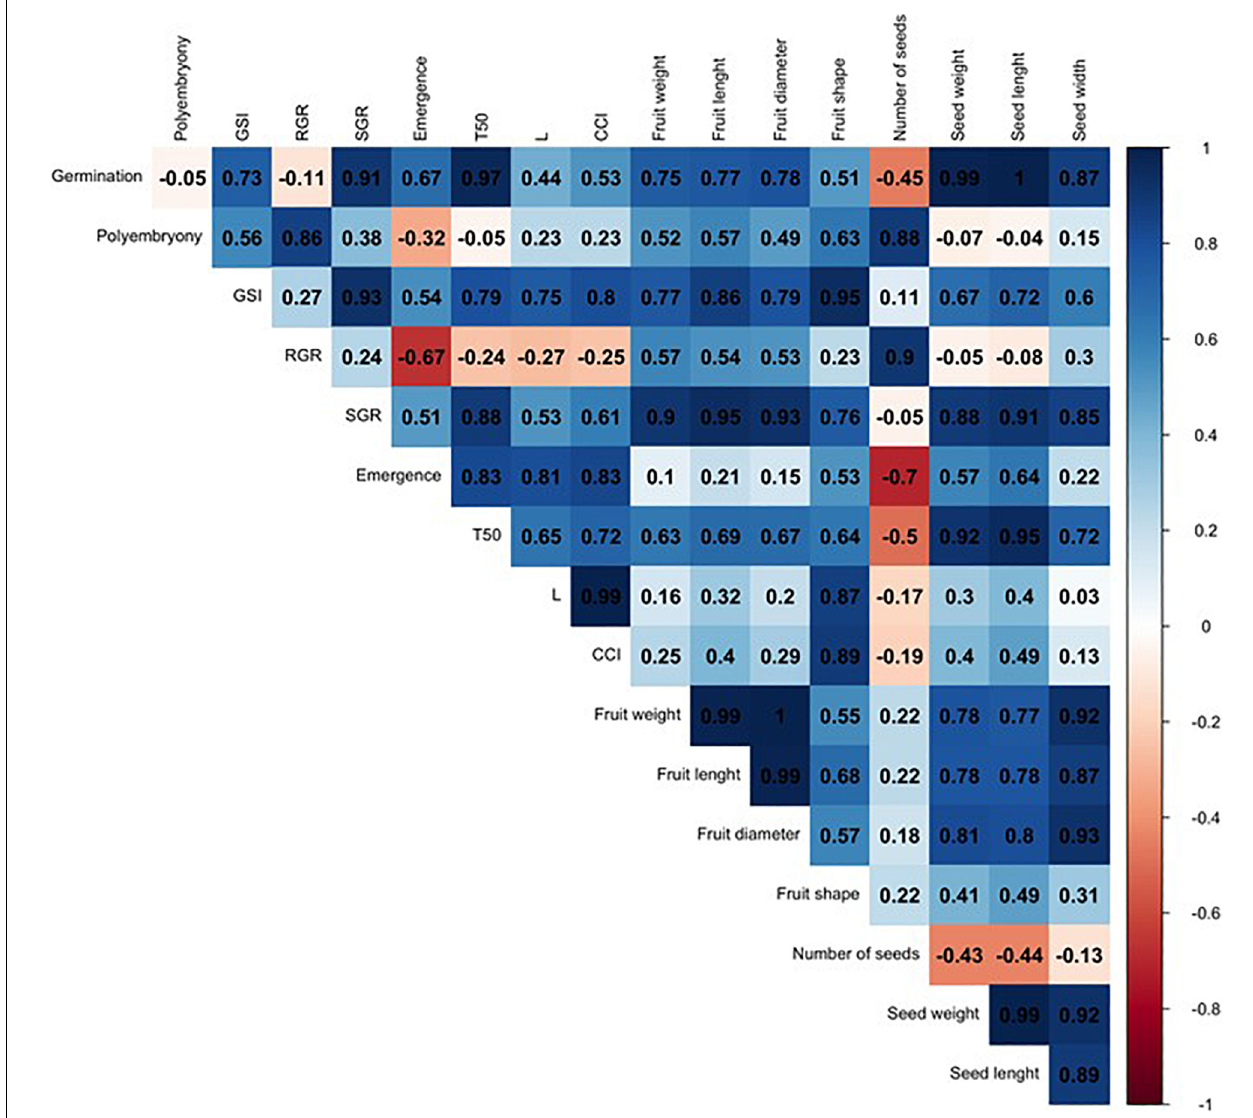
FIGURE 7 | Correlation analysis among the variables studied for US-897 rootstock. The numbers display the Pearson’s correlation coefficient (r). Blue cells indicate positive correlations among the variables (1) and the red cells indicate negative correlations (–1). The color density and numbers reflect the scale of correlation. Variables: germination; polyembryony; GSI: germination speed index; RGR: root growth rate; SGR: shoot growth rate; emergence; T50: days to reach 50% of the total emergence; L : lightness value; CCI: citrus color index; fruit weight; fruit length; fruit diameter; fruit shape; number of seeds per fruit, seed weight; seed length; and seed